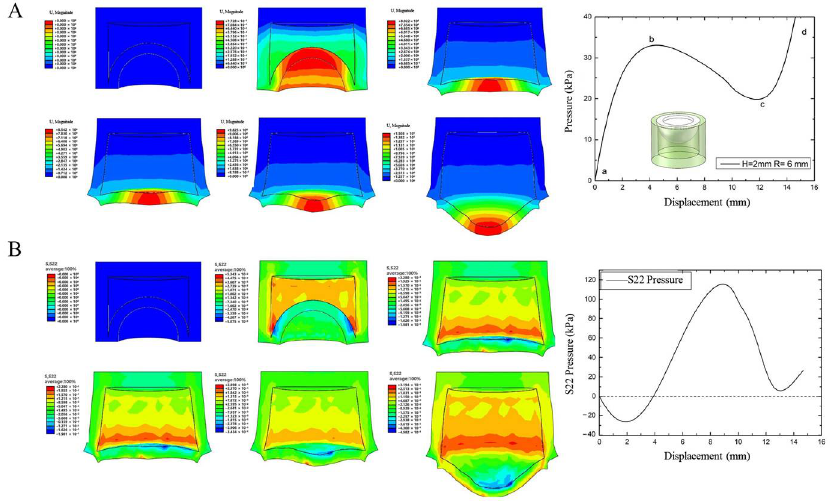
Figure 2. ( A ) The deformation cloud diagram and load-displacement curve of the driven dia-phragm, ( B ) The stress cloud diagram and the stress-displacement curve.